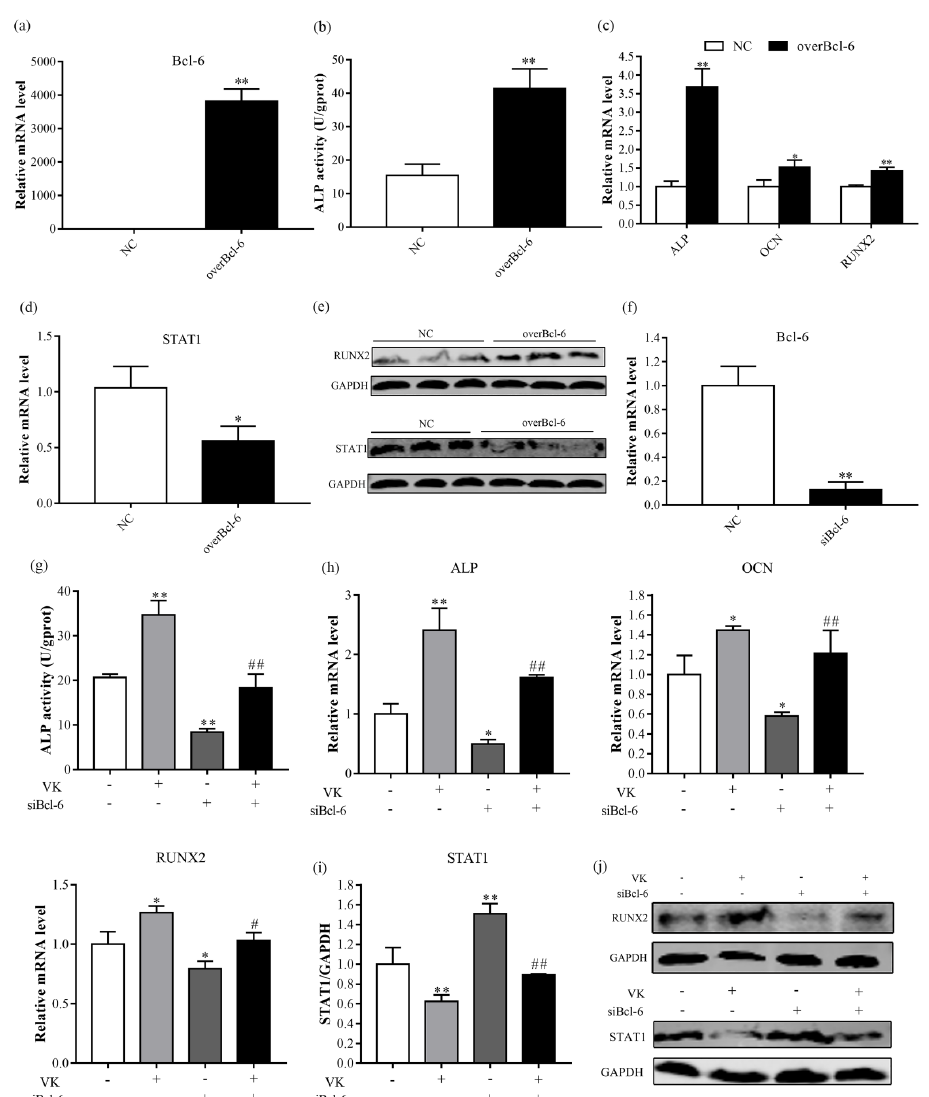
Figure 5. VK 2 promoted osteogenesis by inhibiting STAT1 via Bcl-6 in C3H10 T1/2 clone 8 cells. ( a ) Bcl-6 overexpression efficiency. ( b ) ALP activity after Bcl-6 overexpression. ( c , d ) The mRNA levels of ALP, OCN, RUNX2 ( c ), and STAT1 ( d ) after Bcl-6 overexpression. ( e ) The protein levels of RUNX2 and STAT1 after Bcl-6 overexpression. ( f ) Knockdown efficiency of Bcl-6. ( g ) ALP activity after Bcl-6 knockdown during VK 2 induced osteoblastic differentiation. ( h , i ) The mRNA levels of ALP, OCN, RUNX2 ( h ), and STAT1 ( i ) after Bcl-6 knockdown during VK 2 induced osteoblastic differentiation. ( j ) The protein levels of RUNX2 and STAT1 after Bcl-6 knockdown during VK 2 induced osteoblastic differentiation. The data are presented as the mean ± SEM; *, ** denotes a significant difference with respect to the control group ( p < 0.05); #, ## denotes a significant difference with respect to the siBcl-6 group ( p <